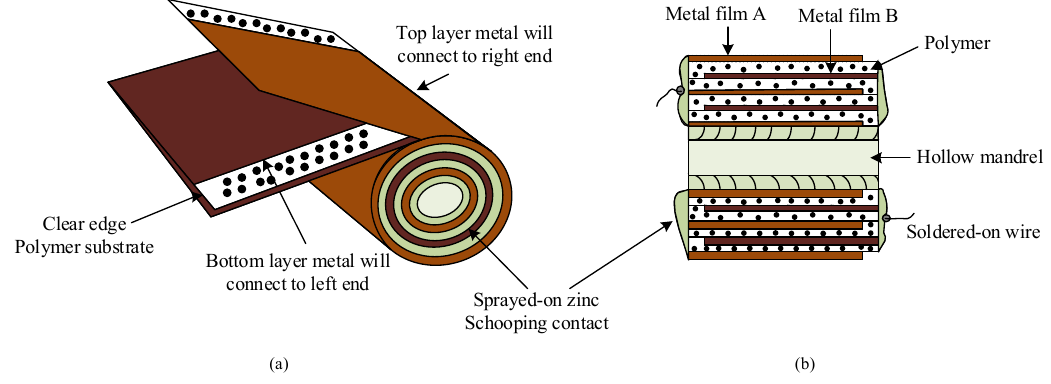
Figure 2. Construction of a metallized polypropylene film capacitor (MPPF-Cap): ( a ) cylinder construction; ( b ) cross section of the cylinder.